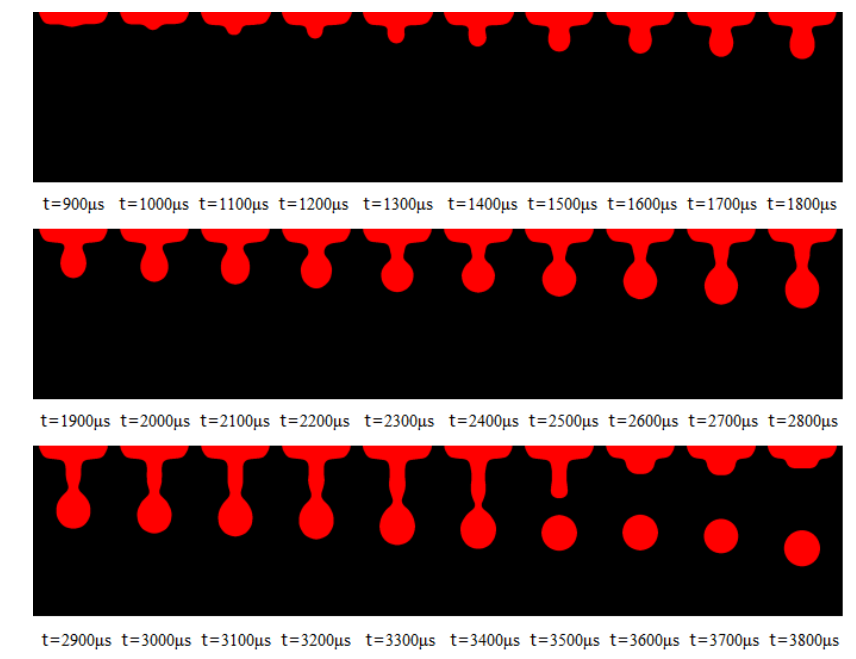
Figure 14. The area where the nozzle and droplet are located at different times.